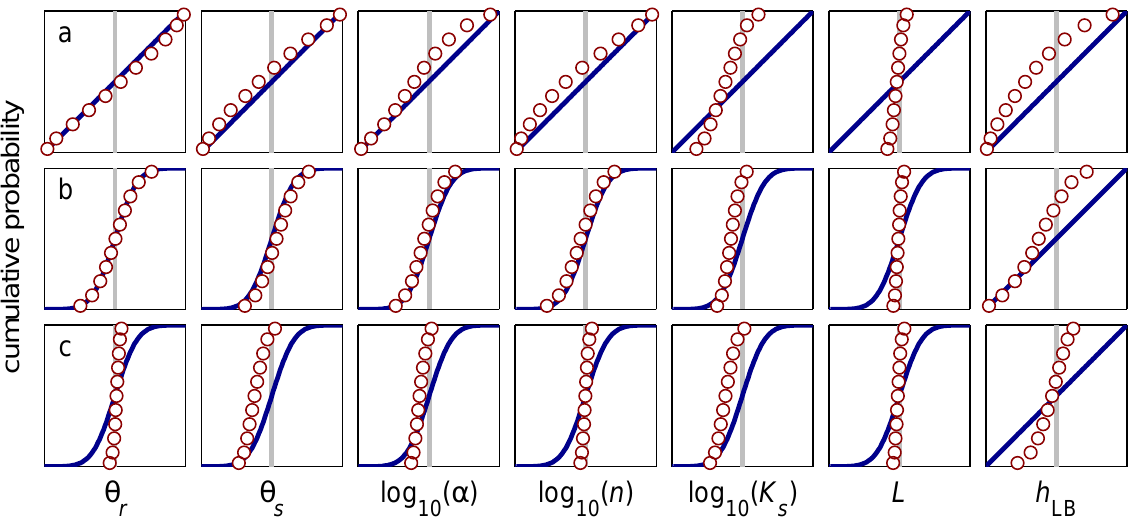
Fig. 3. Cumulative prior and posterior probability distributions using synthetic soil water content data and three different unbiased prior probability distributions: (a) multivariate uniform distribution (Prior 1), (b) multivariate normal distribution without correlation among the soil hydraulic parameters (Prior 2), and (c) multivariate normal distribution with correlation among the soil hydraulic parameters (Prior 3). The blue lines represent the prior distributions. The red circles denote the 2.5, 10, 20, 30, 40, 50, 60, 70, 80, 90, and 97.5% quantiles of the posterior distributions, respectively. The grey lines mark the parameter values used to generate the data. The x-axes cover the bounds listed in Table 1.